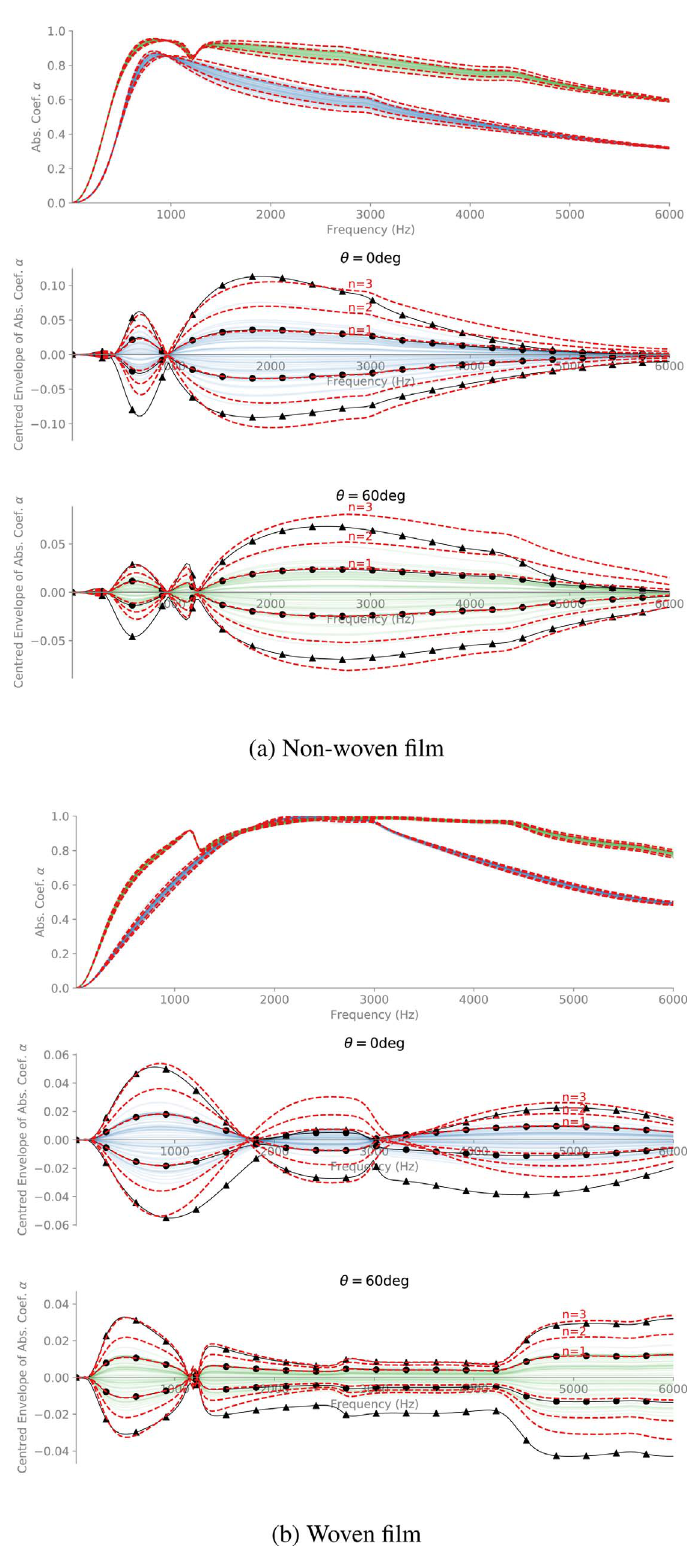
Figure 4. Case of a varying thin fi lm placed over a poro-elastic slab with a rigid backing. Comparison between Monte Carlo envelopes (realisations in blue/green, realisation-wise standard deviation envelope with bullets (cid:7) and extremal envelopes with triangles N ) and envelope from the proposed method (dashed red, n being the multiplier to the standard deviation of the varying parameter). Absorption coef fi cient (top most axis) and centred envelopes (two lower axes) for two angles of incidence (0 (cid:3) in blue and 60 (cid:3) in